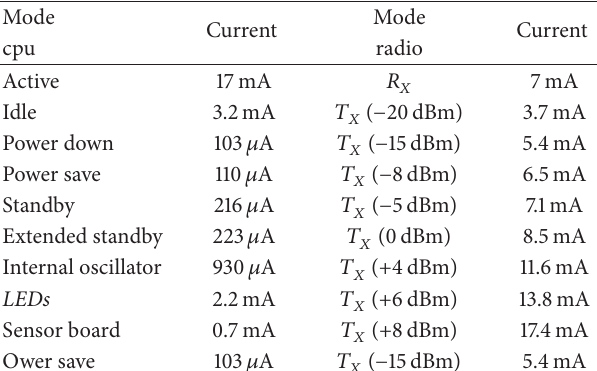
Table 2: Power model for mica mots.